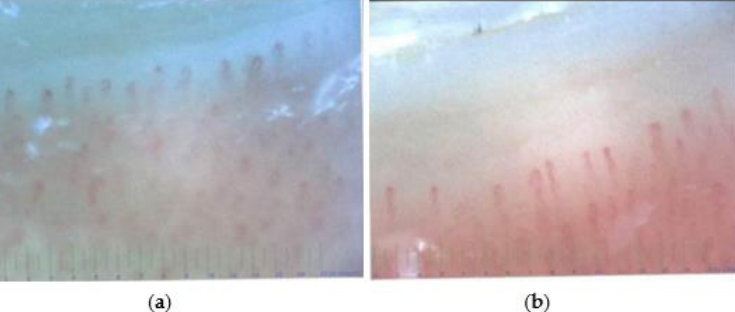
Figure 4. Capillary microscopy at the nailfold. Nailfold microscopy showed mostly regular capil- laries with occasional non-pathological dilatations, regular density, and regular blood flow. Thus, microangiopathy could not be detected. Left side ( a ): left digit V. Right side ( b ): right digit IV.